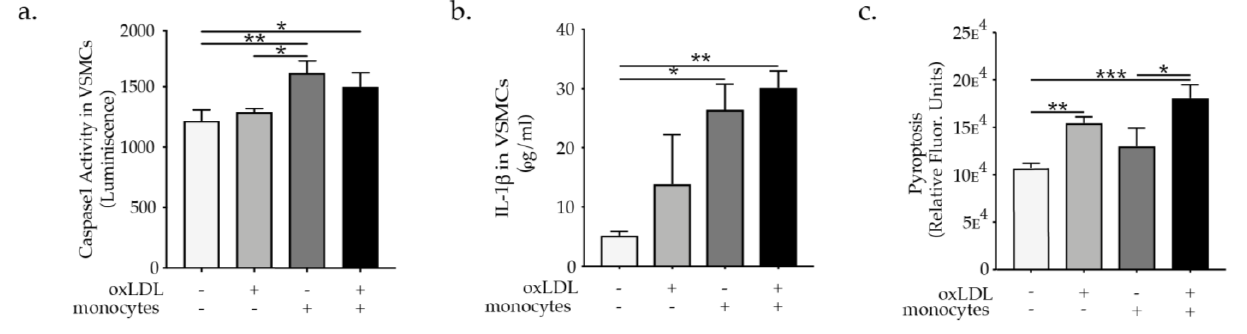
Figure 2. Graph bars represent the mean ± SEM of mRNA expression of ( a ) Oct-4 and ( b ) KLF-4 indicating VSMC phenotypic switch upon oxLDL treatment or co-culture with monocytes or or oxLDL-activated monocytes, as indicated, with n = 6/group and * p < 0.05, ** p < 0.01, and *** p < 0.001, one-way ANOVA.